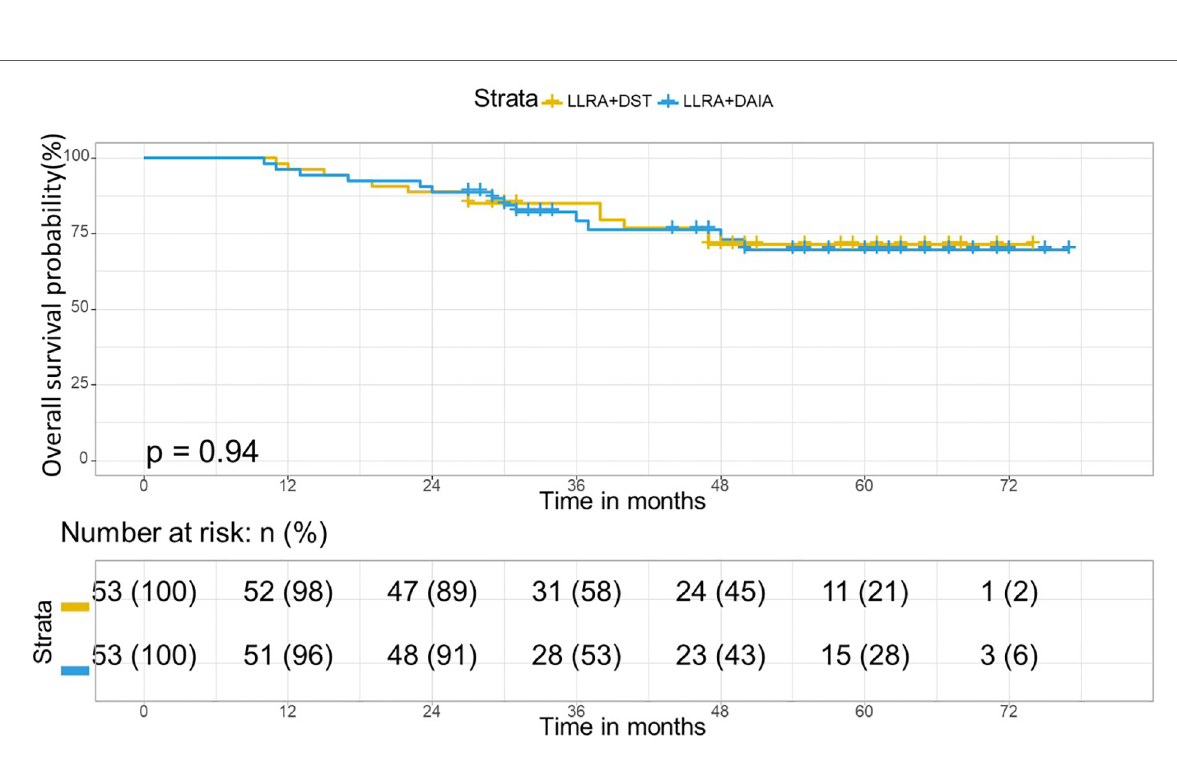
FIGURE 4 Overall survival curve in matched cohort of LLAR+DST and LLAR+DAIA groups. In the matched cohort, in the LLAR+DST group, 3- year and 5-year Overall survival rates were 79.2 and 71% respectively and they were 79 and 69.4% respectively in the LLAR+DEIA group. There was no signi fi cant difference between the LLAR+DST and LLAR+DEIA groups ( P